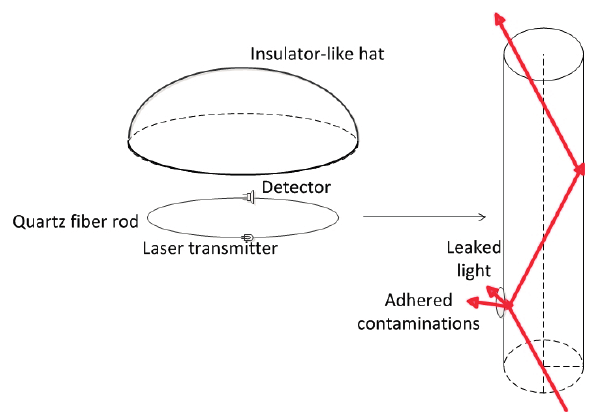
Figure 2. Sketch of the on-line measurement apparatus.